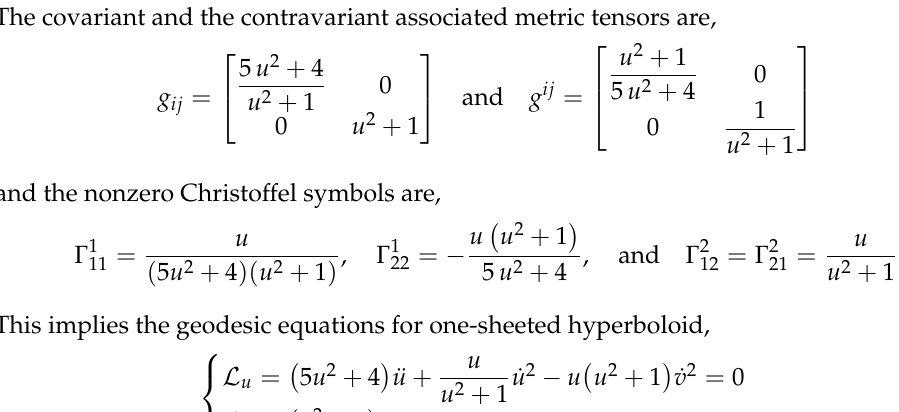
(cid:110) u , v , u cos v − v sin u